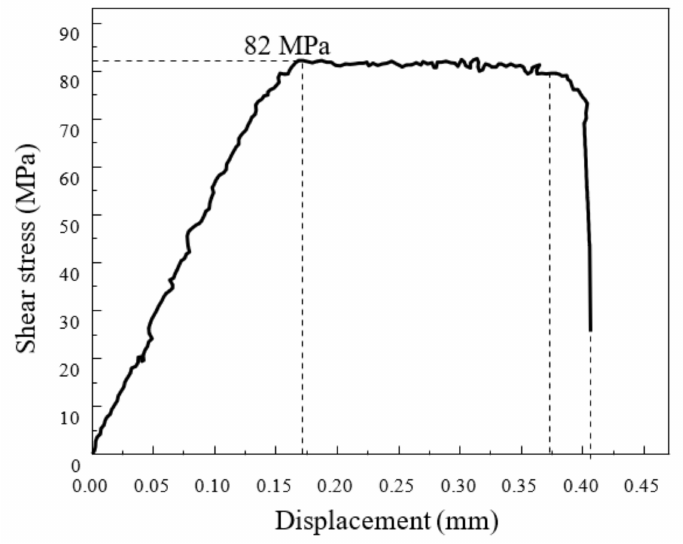
Figure 9. The shear stress-displacement curve of the shearing